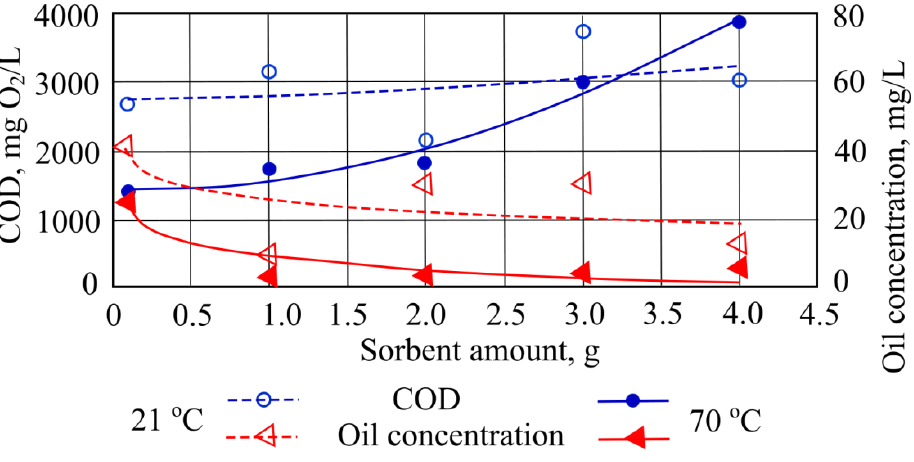
Figure 3. COD and oil concentrations when different quantities of straw sorbent are added to the wastewater.